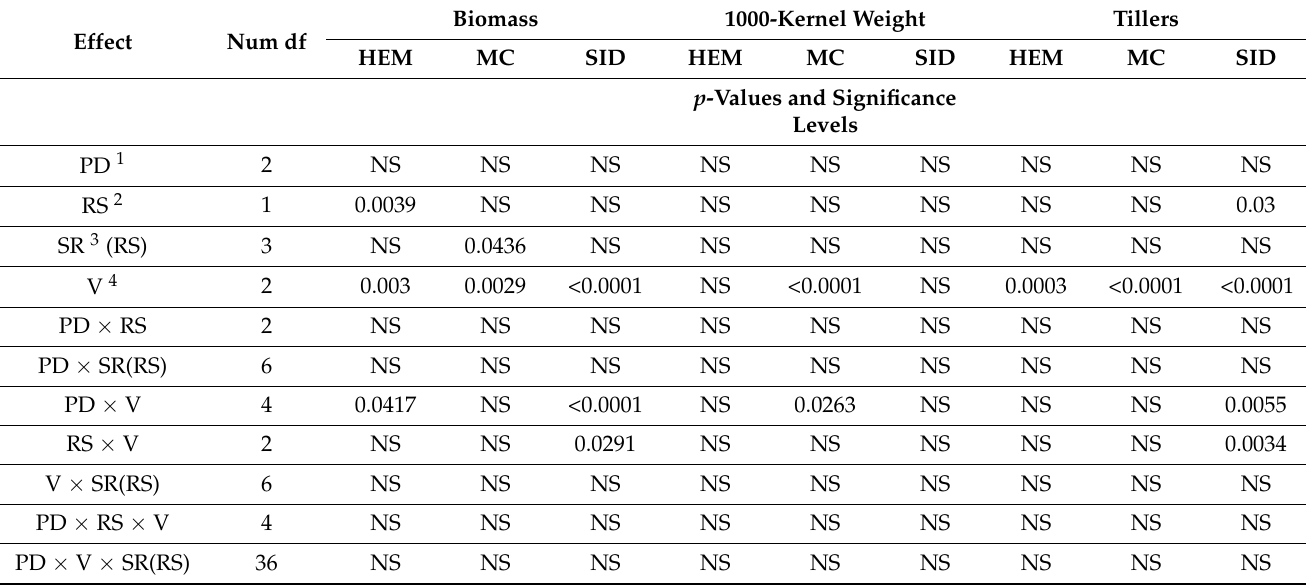
Table 4. Analysis of variance showing the effect of planting date, variety, row spacing, and seed rate nested within row spacing and interaction among them on winter wheat biomass, 1000-kernel weight, and tillering. Location names are abbreviated HEM (Hemingford), MC (McCook), and SID (Sidney).